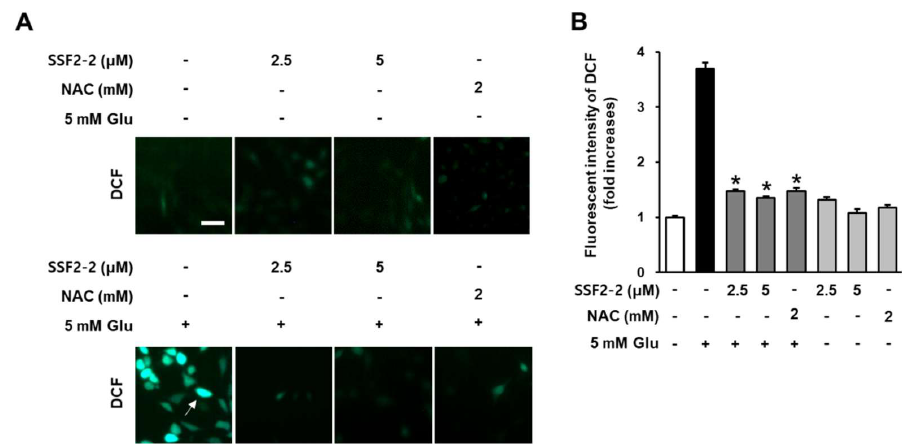
Figure 3. Effects of SSF2-2 on glutamate-induced increases in intracellular reactive oxygen species (ROS). HT22 cells were incubated for 24 h with 5 mM glutamate (Glu) with or without SSF2-2 and N-acetylcysteine (NAC), and then stained with DCFDA. ( A ) Fluorescent images were collected using a fluorescent microscope; ( B ) Fold increases in fluorescent intensity of DCF. White scale bar, 40 µ m. Data represent the mean ± S.E.M., n = 3, * p < 0.05 compared with the glutamate-treated